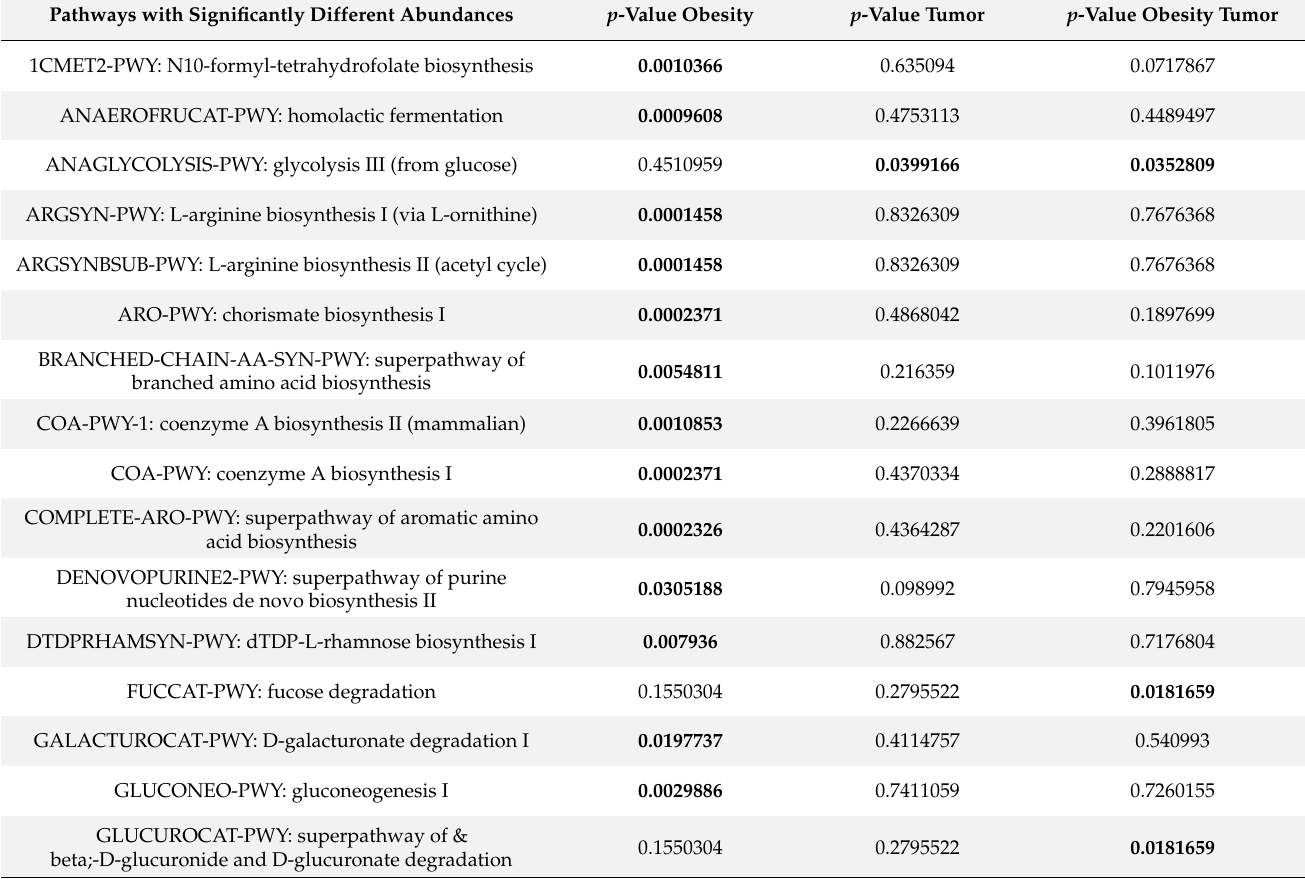
Table 4. Pathways with significantly different